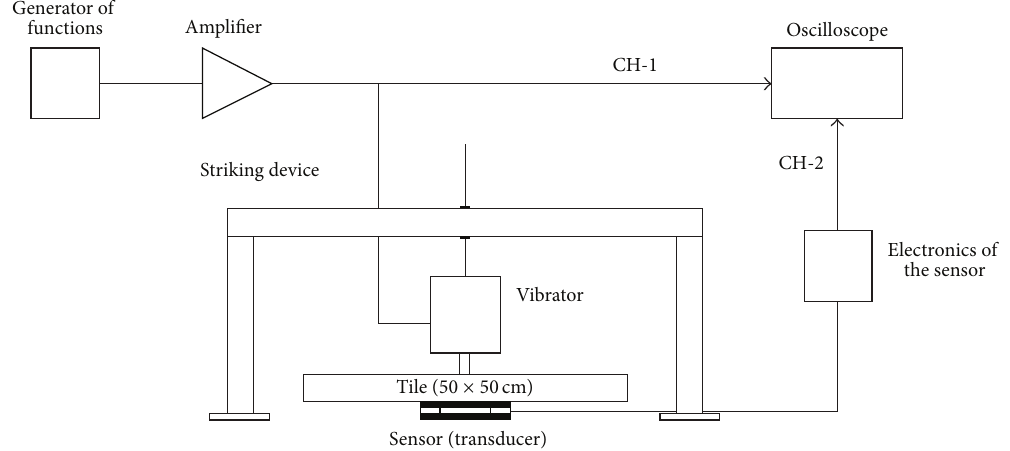
Figure 4: Diagram of the measuring equipment.